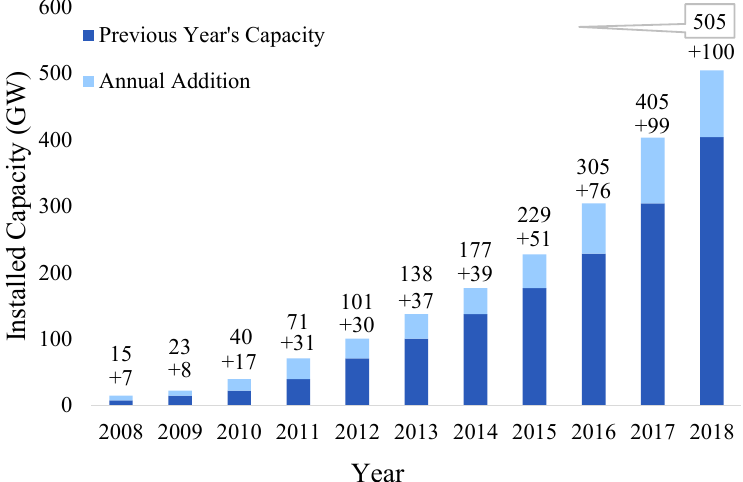
Figure 1. Total installed capacity of photovoltaic (PV) (2008–2018) [3].